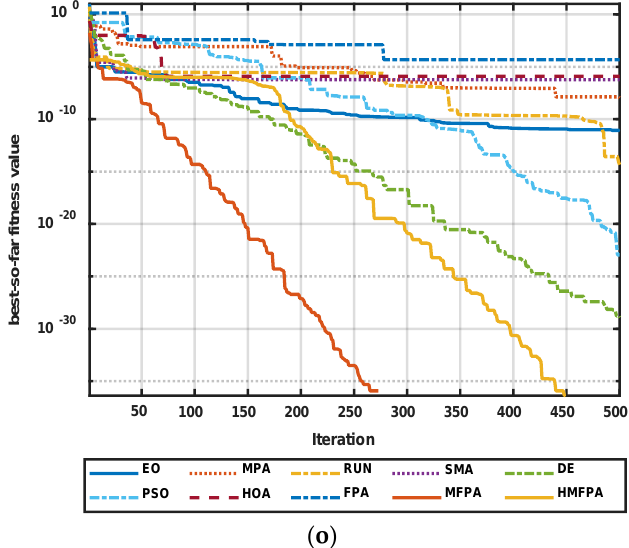
Figure 10. Convergence curve for the NESs: ( a ) Convergence curve for f1; ( b ) Convergence curve for f2; ( c ) Convergence curve for f3; ( d ) Convergence curve for f4; ( e ) Convergence curve for f5; ( f ) Convergence curve for f7; ( g ) Convergence curve for f8; ( h ) Convergence curve for f9; ( i ) Convergence curve for f10; ( j ) Convergence curve for f11; ( k ) Convergence curve for f12; ( l ) Convergence curve for f13; ( m ) Convergence curve for f14; ( b ) Convergence curve for f1; ( n ) Convergence curve for f15; ( o ) Convergence curve for f17.